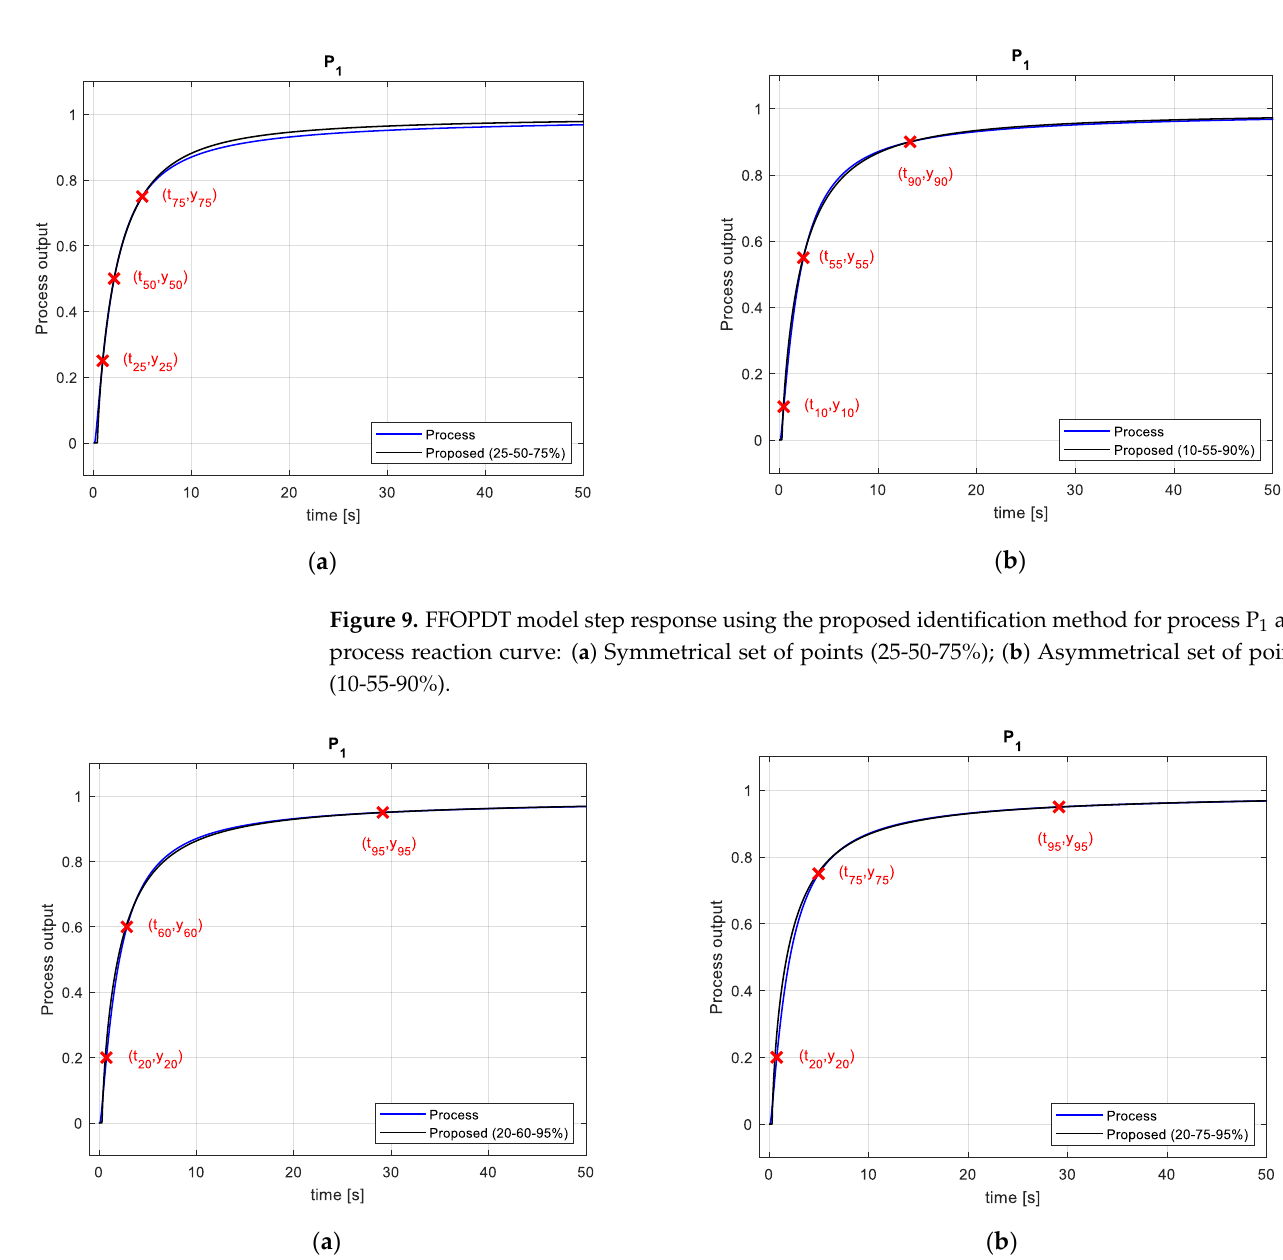
Figure 8. FFOPDT model step response using the proposed identification method for process P 1 and process reaction curve: ( a ) Symmetrical set of points (5-50-95%); ( b ) Symmetrical set of points (10- 50-90%).